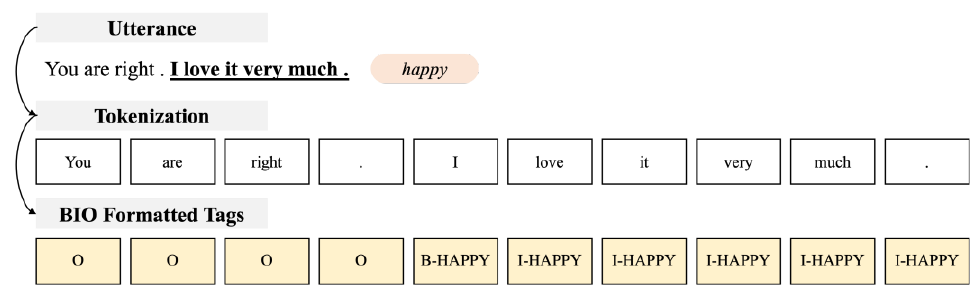
Figure 2. Example of the proposed BIO formatted tags.